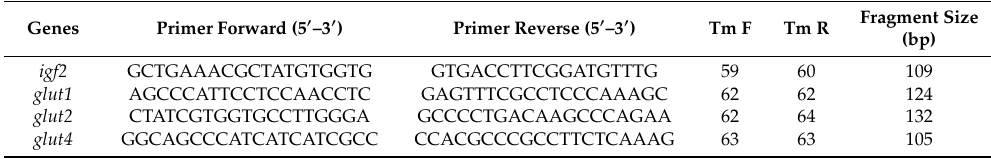
Table 1. glut1 , glut2 , glut4 , and igf2 primer sequences, annealing temperatures, and amplification size of each